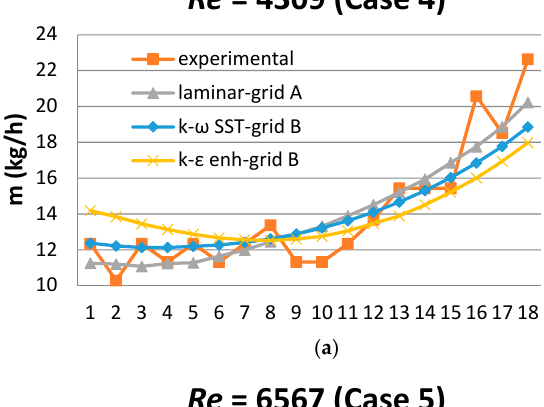
Figure 7. Comparison of the pressure drop against inlet Reynolds number, as predicted by the laminar flow simulations in grids A and B.